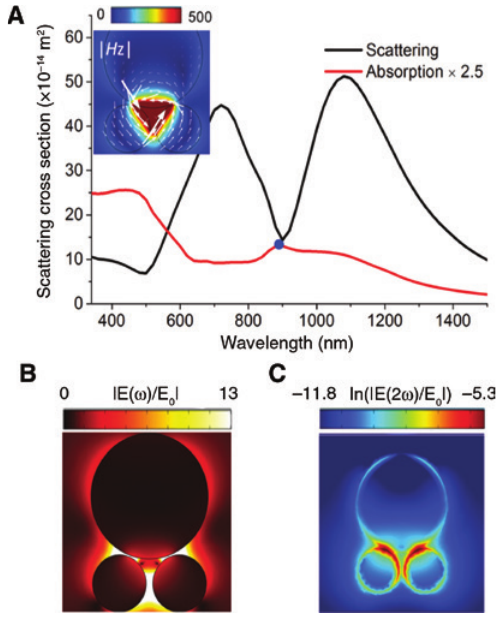
Figure 7: Magnetic Fano resonance-induced second harmonic